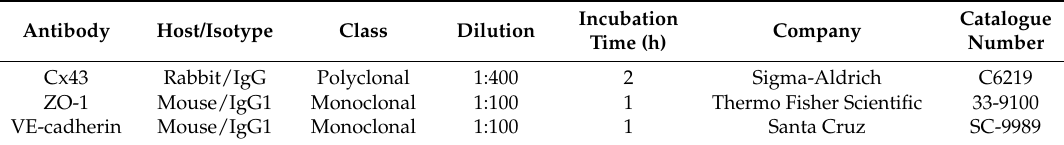
Table 2. List of primary antibodies used for